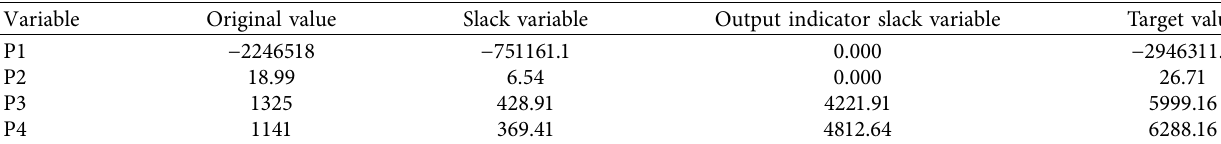
Table 2: Projection summary results of sample